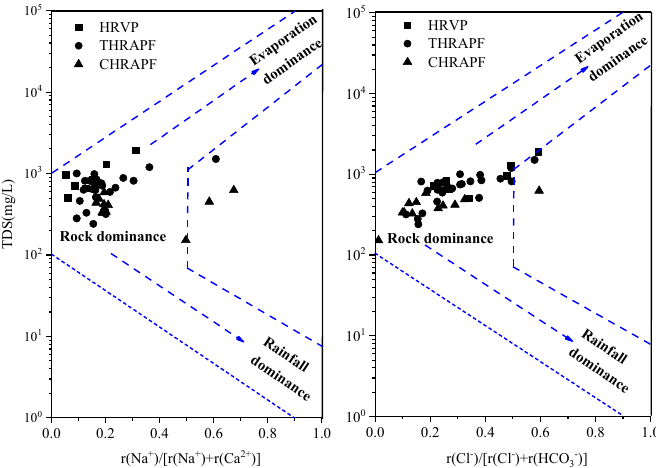
Figure 4. Gibbs diagram for the groundwater in Hutuo River alluvial-pluvial fan.